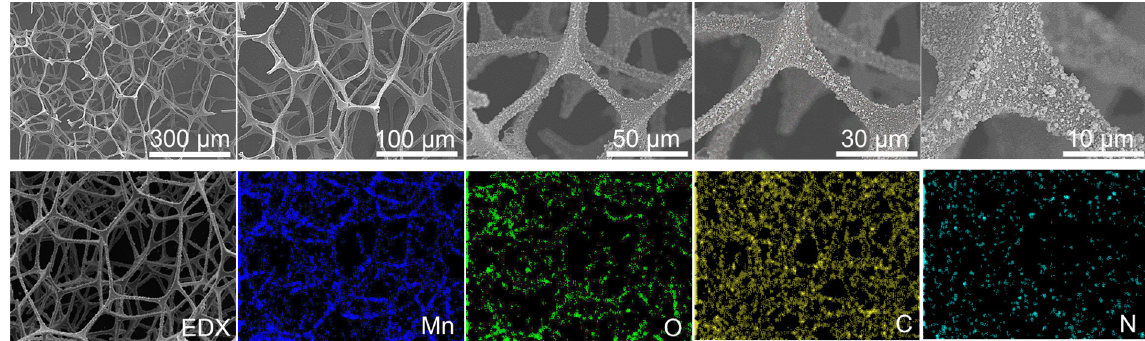
Figure 3. SEM image and EDX mapping of the catalyst MS/PDA/MnOx/GCN.